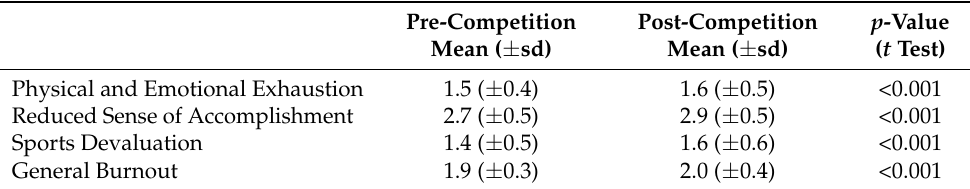
Table 2. Distribution of the pre and post competition mean scores obtained by the athletes, according to ABQ dimensions and general